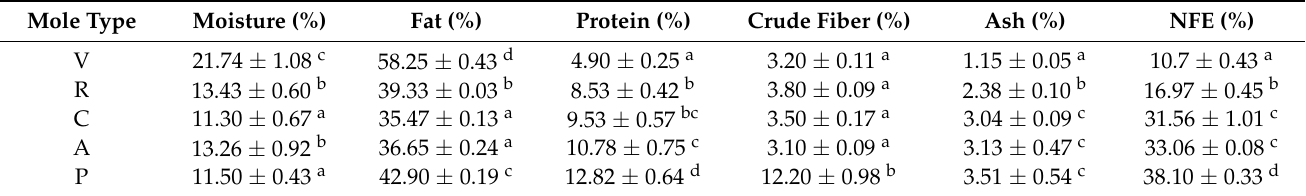
Table 1. Proximal chemical composition of five varieties of mole from the Hidalgo state in